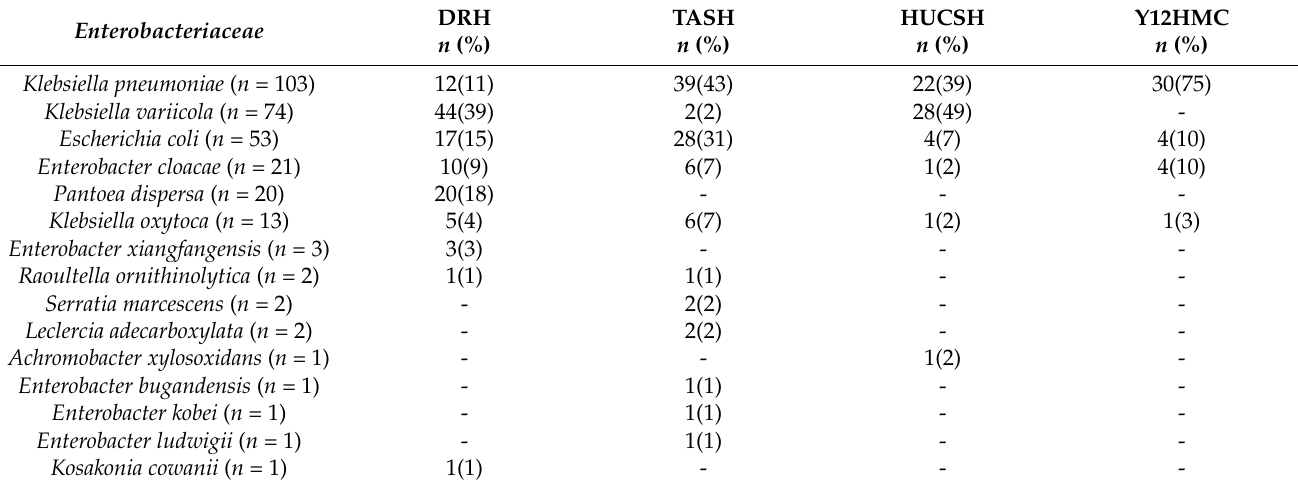
Table 2. Frequency and distribution of Enterobacteriaceae isolated from the patients investigated for sepsis and subjected for whole genome sequence in four Ethiopian